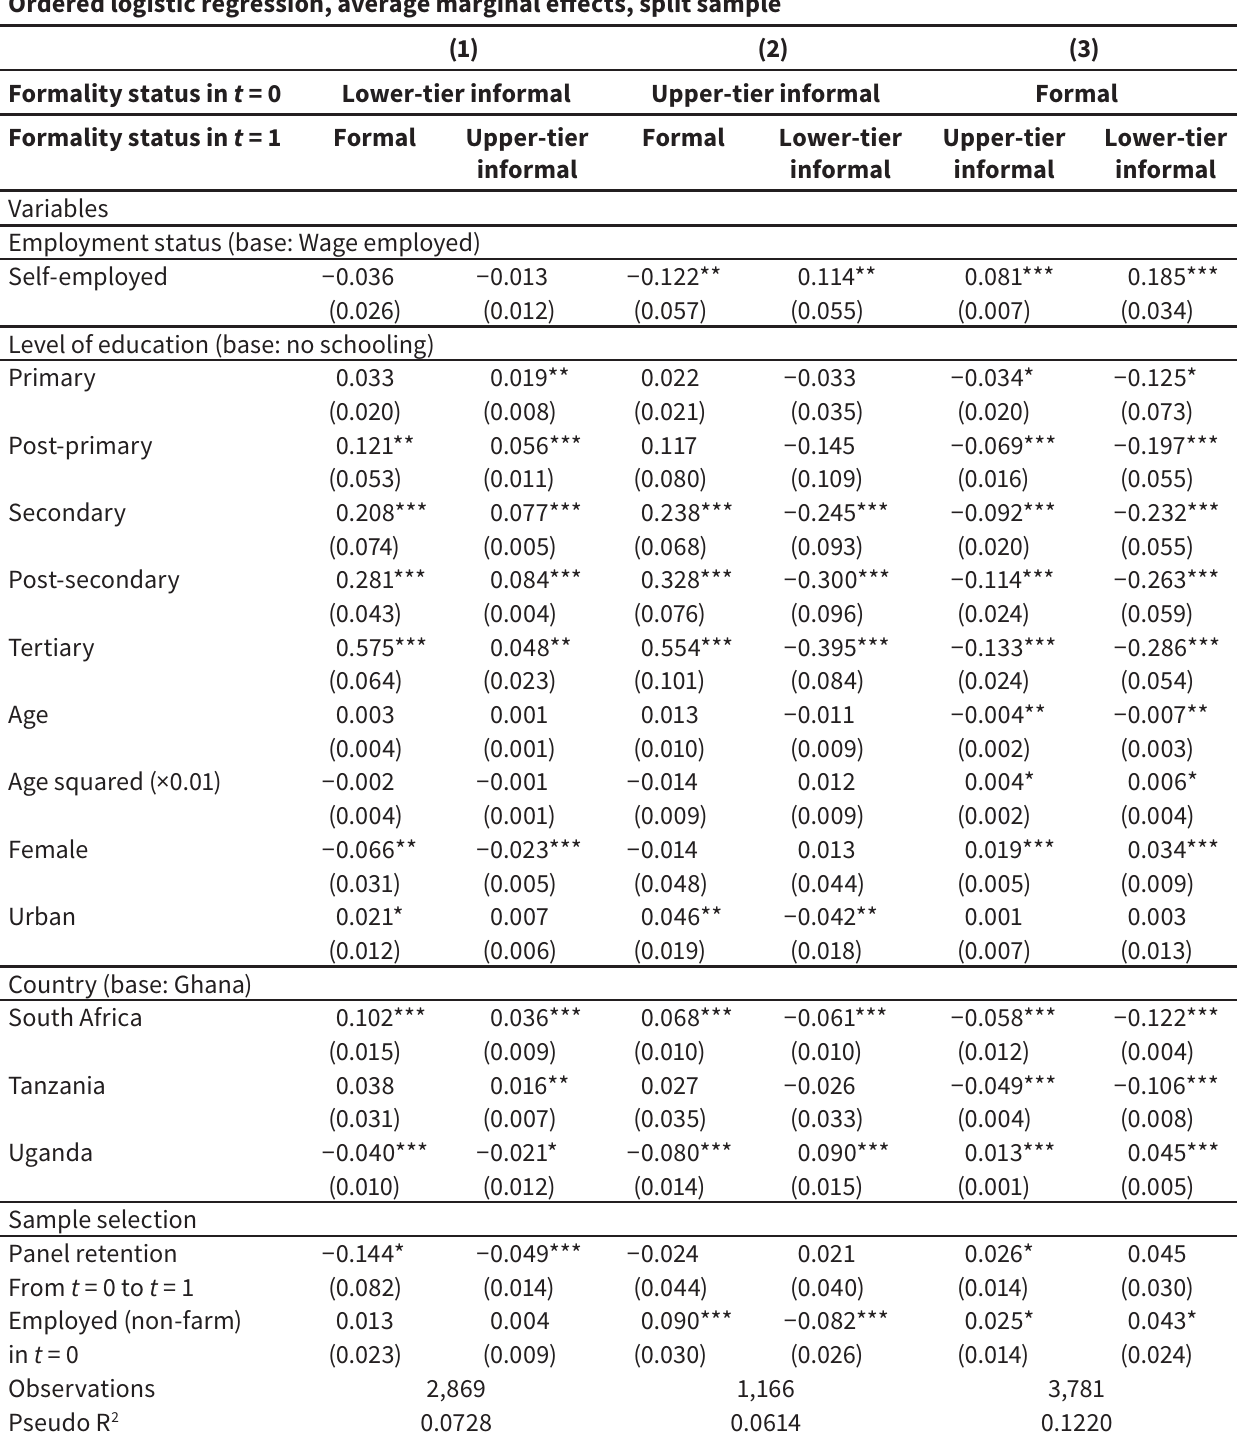
Employment dynamics, using ordered logistic regression Ordered logistic regression, average marginal effects, split